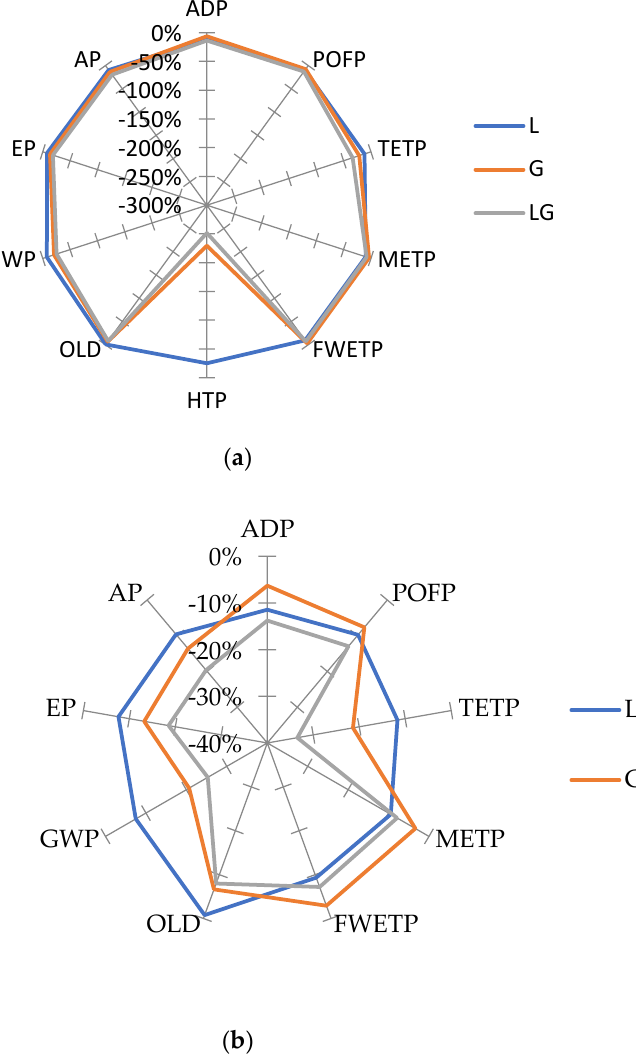
Figure 4. Overview comparisons of all asphalt mixtures: ( a ) for all impact categories; ( b ) for all impact categories except HTP.